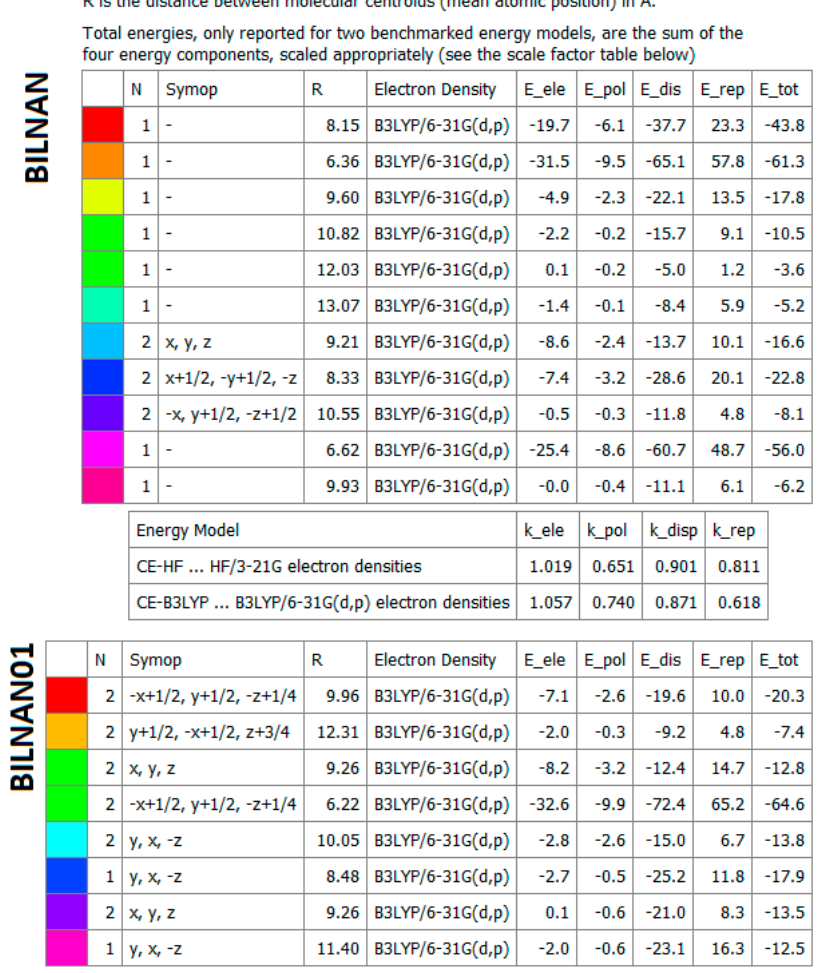
Figure 22. Interaction energies of the molecular pairs related to energy frameworks of captopril, on the left and captopril disulfide, on the right (scale factors for benchmarked energy models).